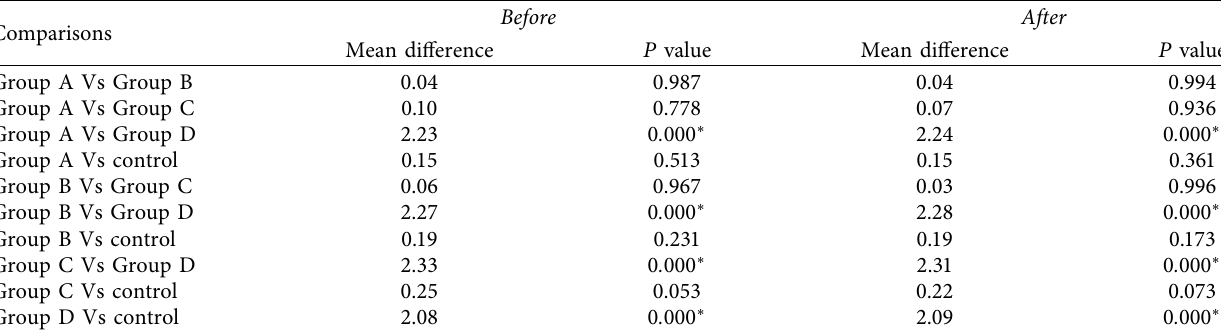
Table 4: Multiple comparison by Tukey Post Hoc